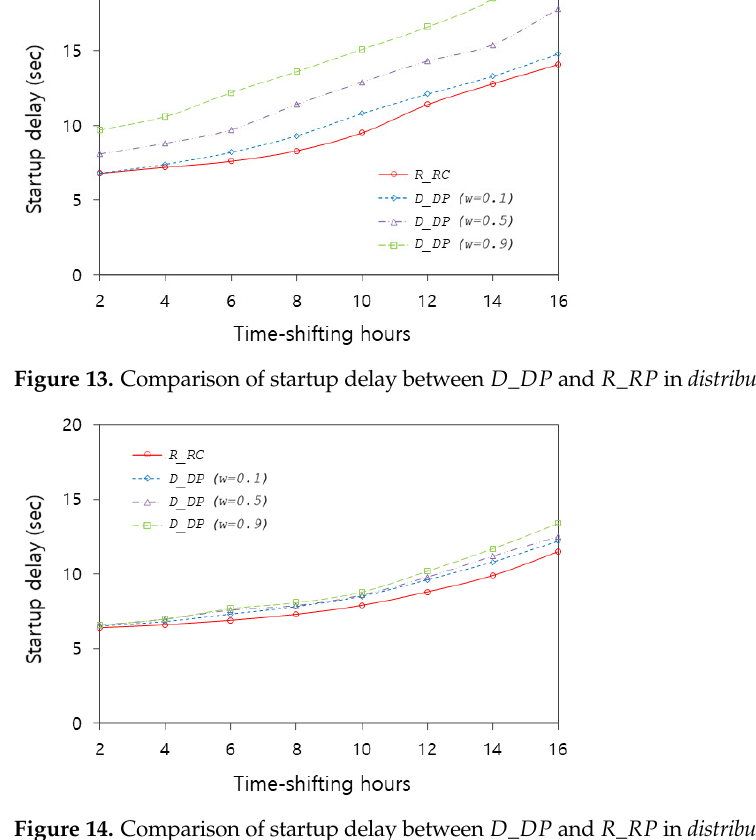
Figure 14. Comparison of startup delay between D _ DP and R _ RP in distribution 3 with a 300 s